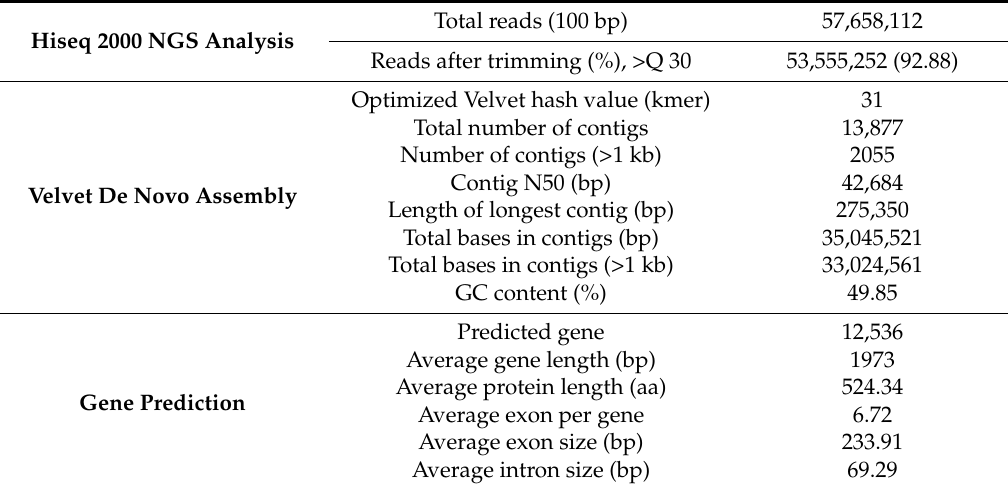
Table 1. Flammulina elastica Genome Sequencing Statistics.